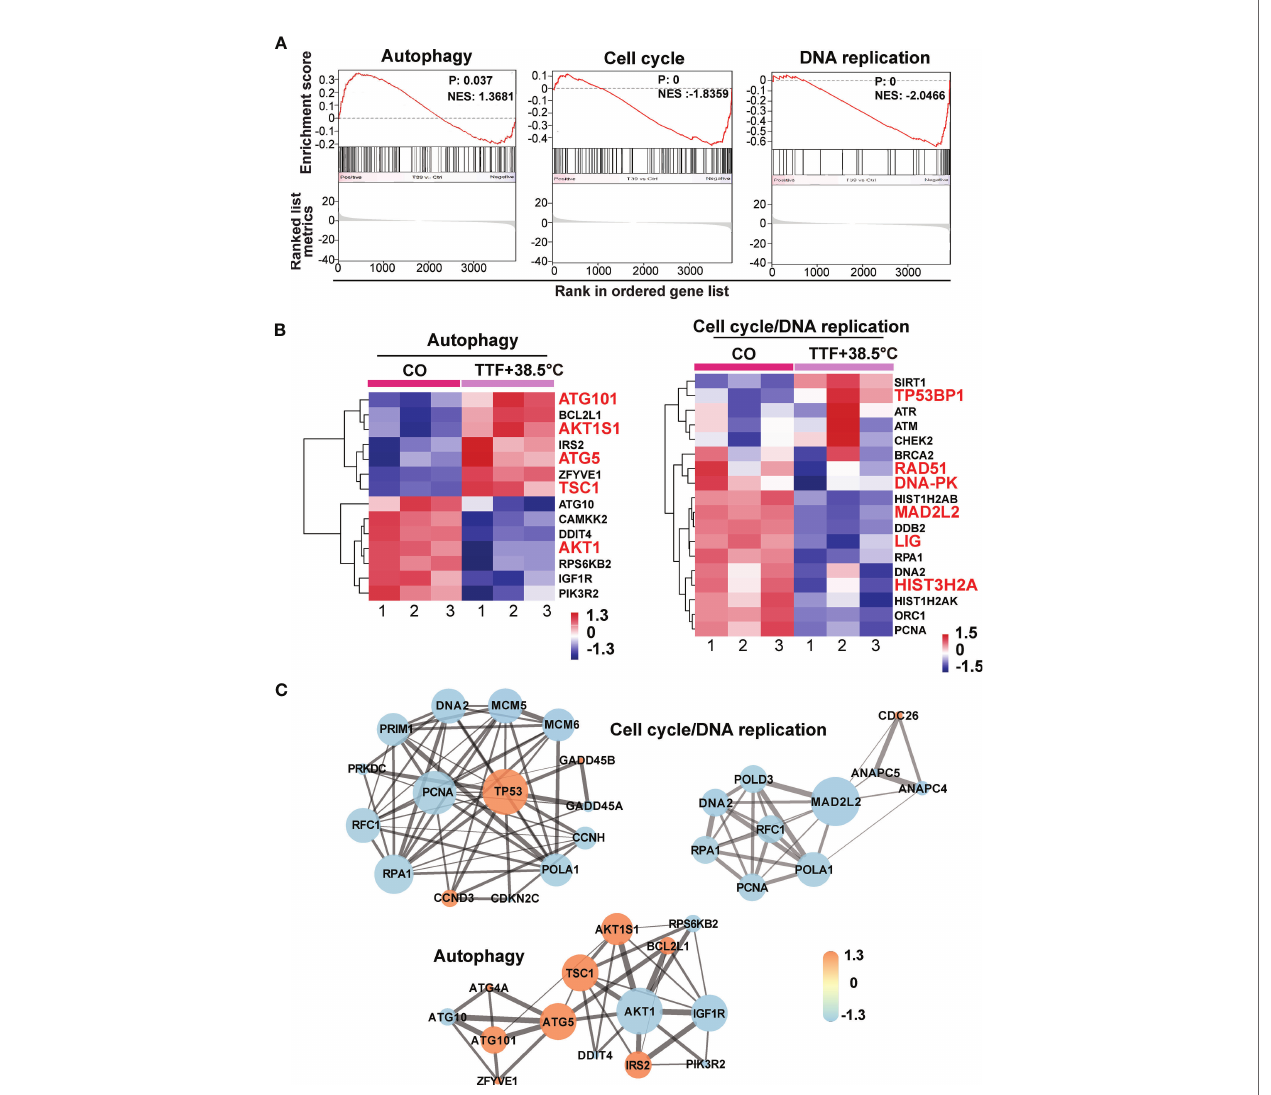
FIGURE 5 | GSEA suggests TTField plus hyperthermia-mediated regulation of autophagy, the cell cycle and DNA replication. (A) The biological pathways that are enriched in the gene array lists were identi fi ed by gene set enrichment analysis (GSEA). Differentially regulated genes in BxGEM cells cultivated at 37°C or at 38.5°C plus TTFields were evaluated. In this way, clustering of an autophagy-related gene set, which positively correlated with the treatment group, was detected (Normalized enrichment score (NES) = 1.3681, P = 0.037, False discovery rate (FDR) = 0.13). Likewise, the clustering of a cell cycle-related gene set was found to be negatively correlated with the treatment group (NES = -1.8359, p = 0, FDR = 0.005). Additionally, the clustering of a DNA replication-related gene set was found to be negatively correlated with the treatment group (NES = -2.0466, P = 0, FDR = 0.006). (B) The most relevant genes of each gene set are shown as heat maps. The name of genes, which were identi fi ed by a Cytoscape/String analysis in the following are enlarged and marked in red. (C) The mRNA array data were analyzed with the open source software platform Cytoscape, which resulted in the visualization of networks of co-expressed genes related to the cell cycle, DNA replication and autophagy. The sizes of the circles indicate the interaction degrees of proteins. The circle colors indicate different fold changes. Orange: upregulation, Lilac: downregulation within a scale from -1.3 to 1.3 as